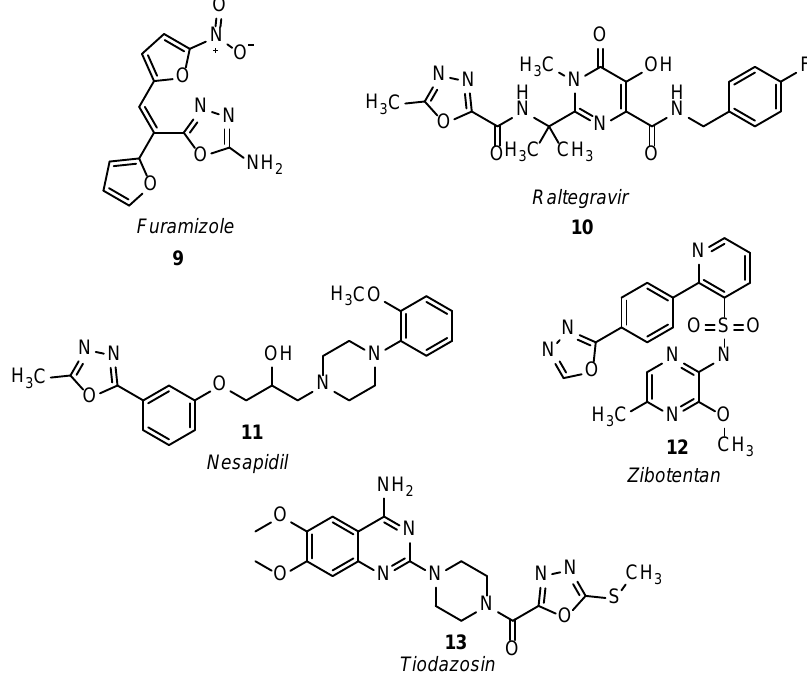
Figure 6. Compounds based on 1,3,4-oxadiazole used in medicine: Furamizole [97], Raltegravir [98], Nesapidil [99], Zibotentan [95], Thiodazosin